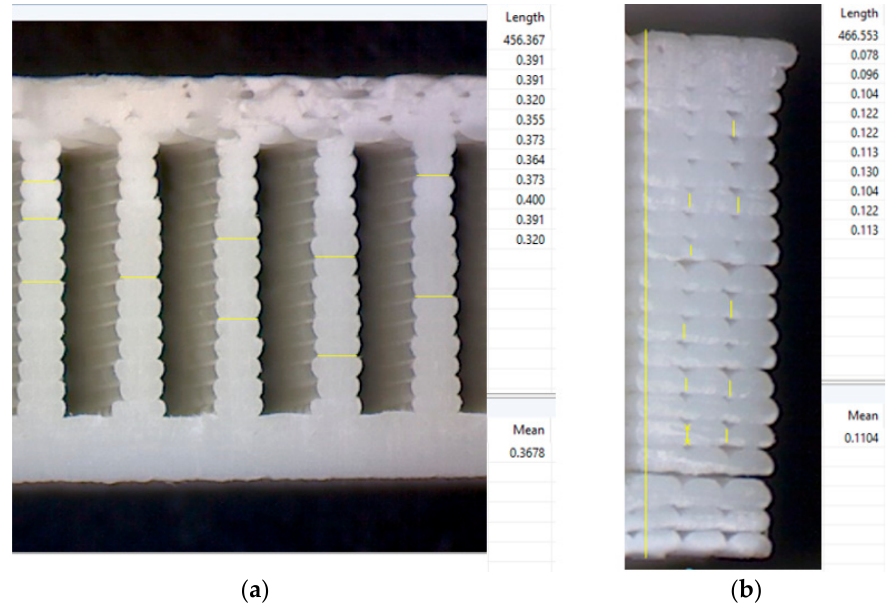
Figure 7. Determination of the contact area between the filaments ( a ) inter layer necking; ( b ) intra layer necking.